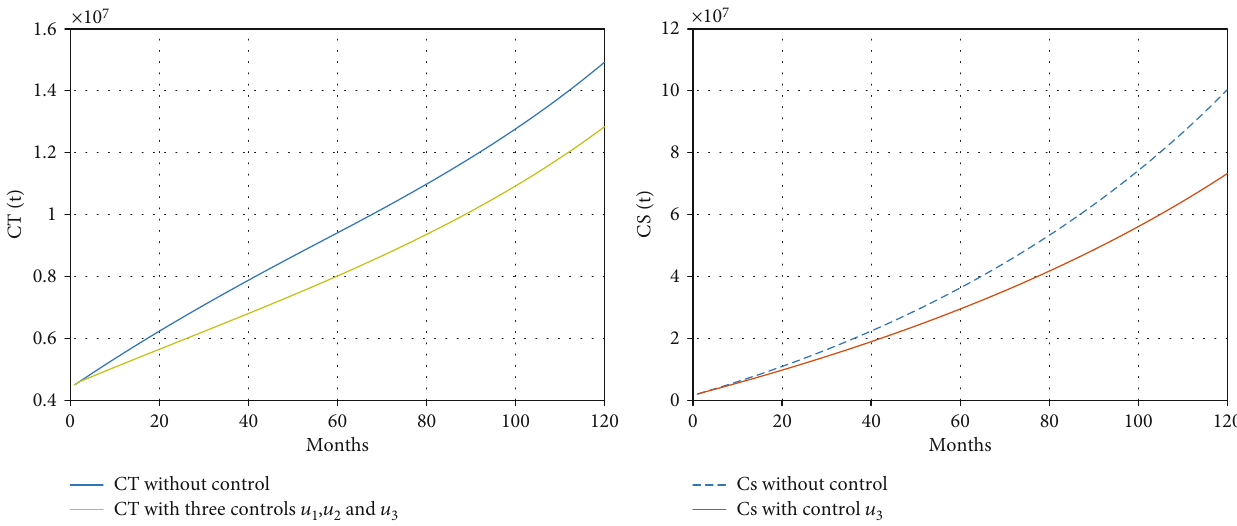
t Þ , u t Þ , and u t Þ : 1 ð 2 ð 3 ð